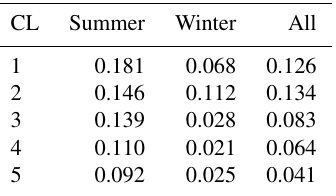
Figure 11. Percentiles (5–25–50–75–95) of ozone seasonal ampli- tudes in clusters; Airbase vs. MACC, first CA. Upper values indi- Table 5. EMD values for each cluster between Airbase and MACC cate the mean seasonal amplitude of each data; second CA. CL EMD (obs–mod) 0.15